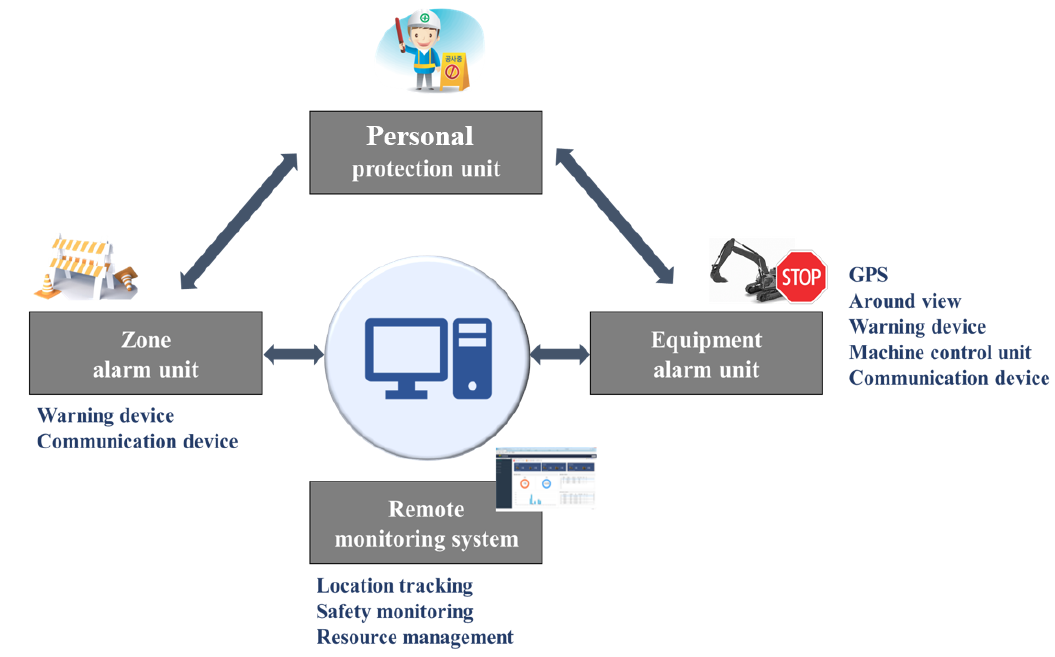
Figure 1. Concept of the robust construction safety system (RCSS).